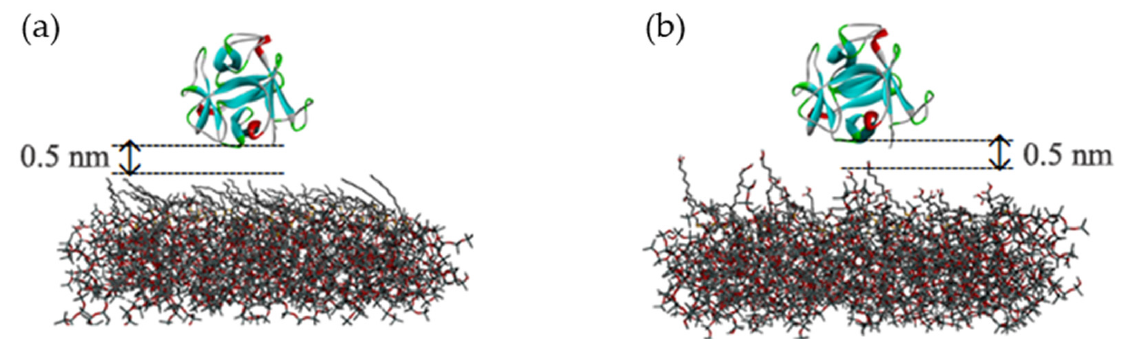
Figure 1. Initial configuration of system: ( a ) protein on the surface of CH3-SAM membrane; ( b ) protein on the surface of COOH-SAM membrane.